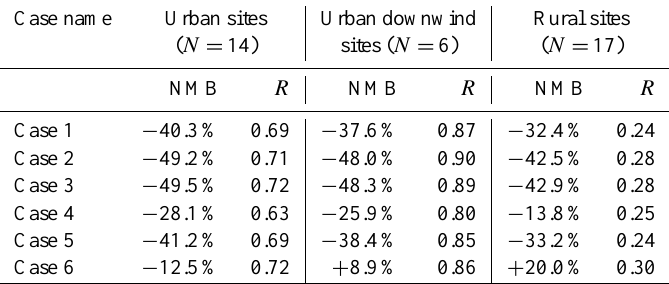
Table 6. Normalized mean bias (NMB) and correlation coefficient ( R ) between the predicted SOA for the simulations and observations reported by Zhang et al. (2007). The number of sites in the comparison is in